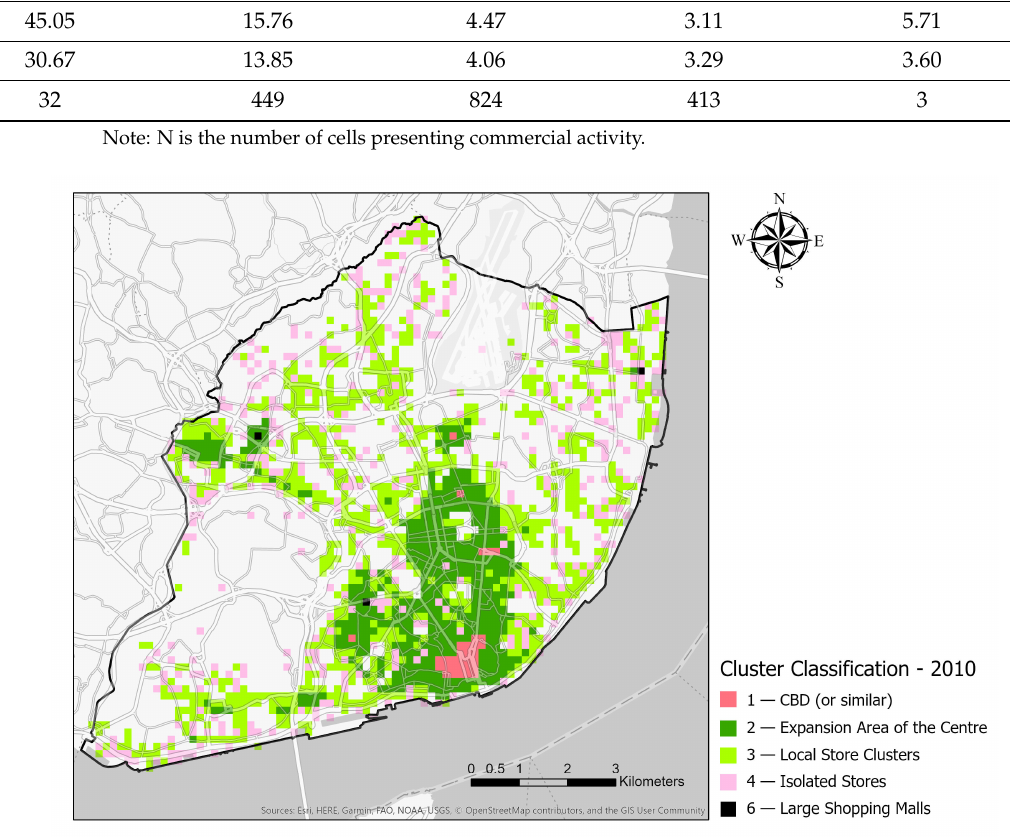
Figure 4. Cluster Classification—2010.